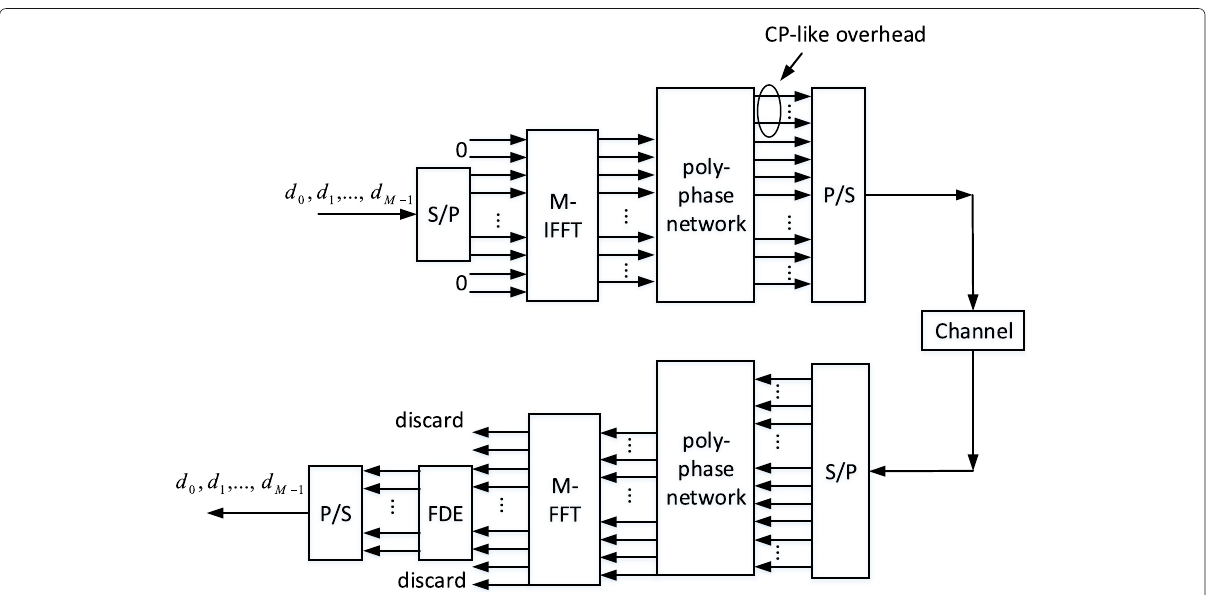
Fig. 2 Pulse-shaped OFDM transceiver structure with efficient implementation of pulse shaping by a polyphase